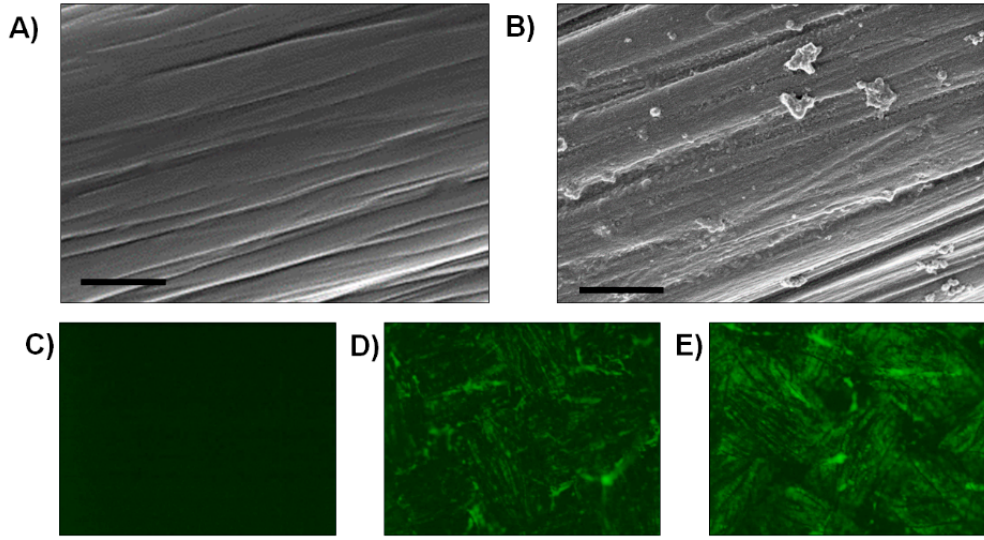
Figure 5. SEM images of ( A ) bare carbon cloth and ( B ) chitosan-hydrogel-coated carbon cloth. Scale bar, 1 µm. Fluorescence microscopic images of ( C ) chitosan-hydrogel-coated carbon cloth